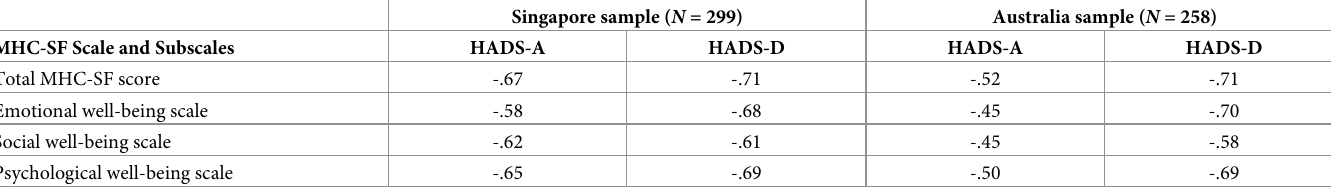
Table 10. Pearson’s correlations of MHC-SF and HADS.